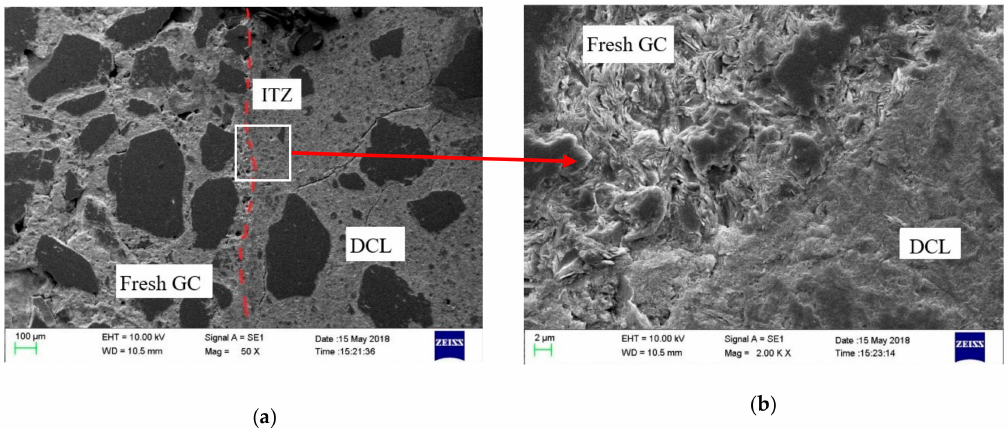
Figure 6. SEM pattern of specimen GC2-D1-33-Y. ( a ) Magnification of 50 times. ( b ) Magnification of 2000